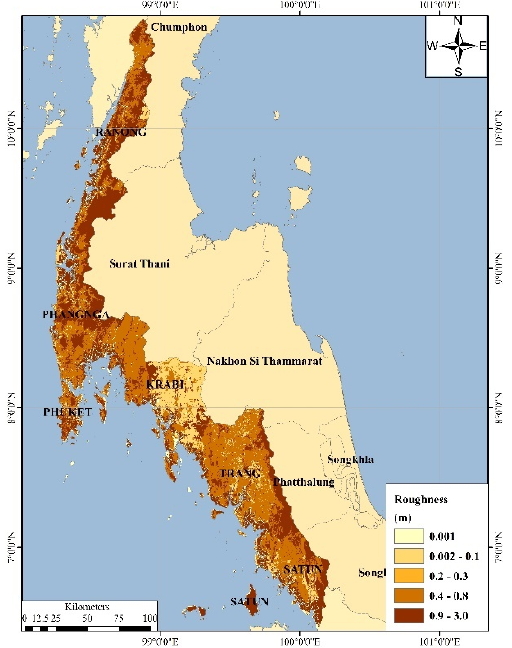
Figure 3. Roughness heights of the study area along the coast of the Andaman Sea.